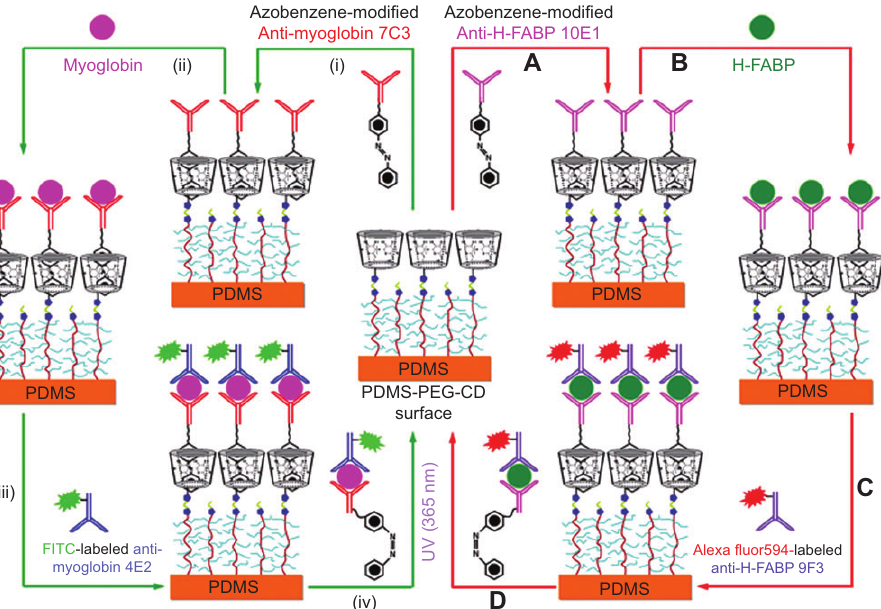
Figure 8 Host – guest interaction-based sandwich fluoroimmunoassay of the cardiac marker myoglobin and H-FABP, and the regeneration of the PDMS – PEG – CD surface under UV irradiation: left side for myoglobin [(i) → (ii) → (iii) → (iv)]; right side for H-FABP [(A) → (B) → (C) → (D)] (Zhang et al. 2011 ).